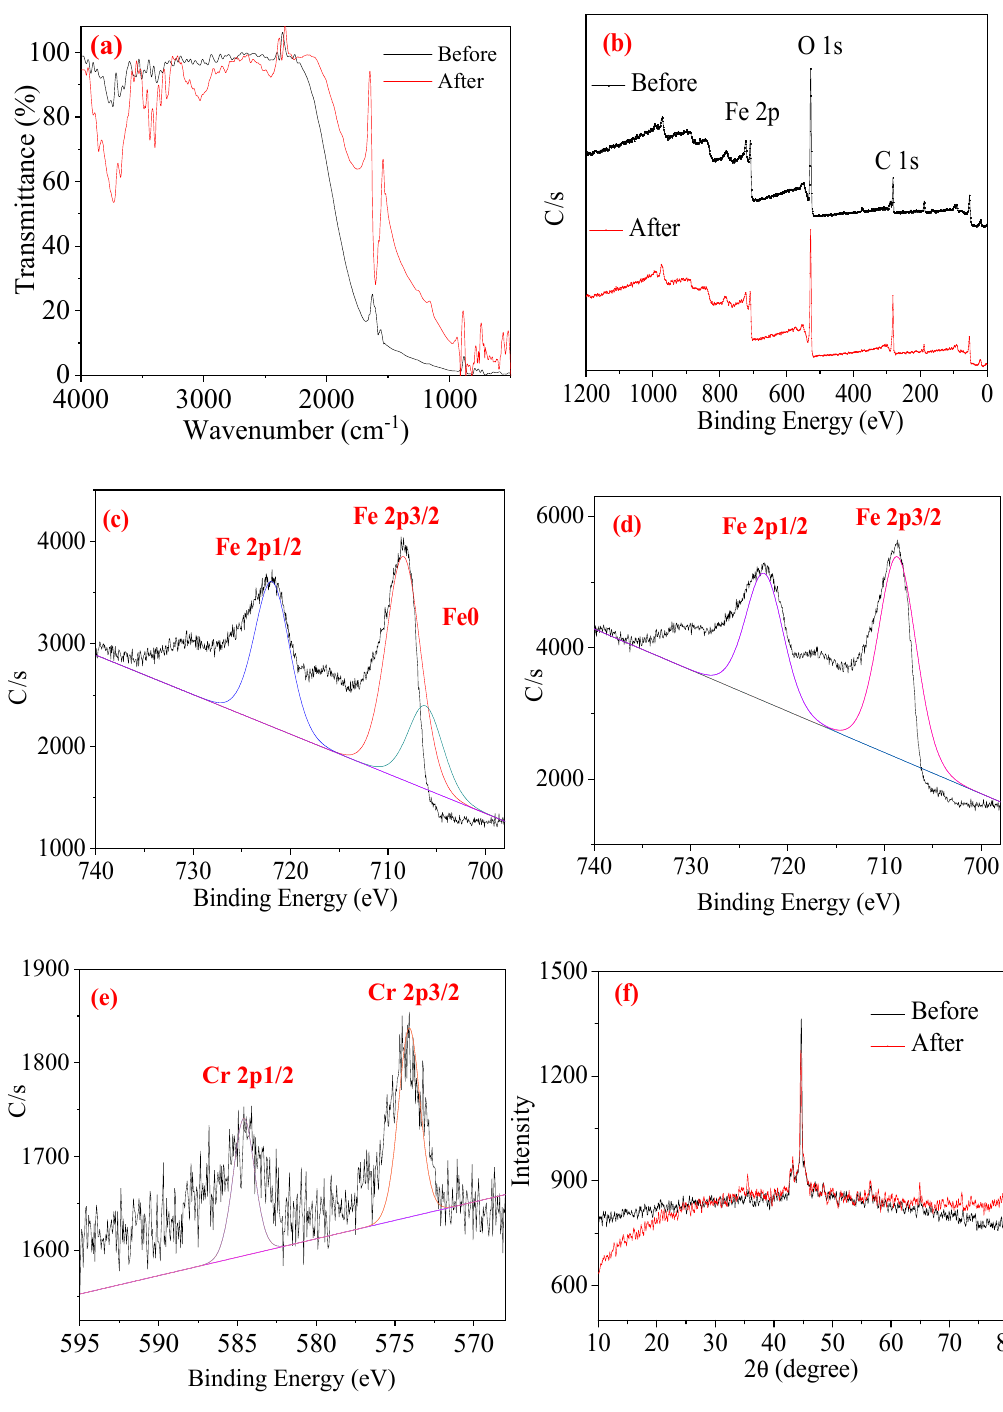
Figure 9. ( a ) The FTIR results of nZVI pre- and post- reaction with Cr(VI); ( b ) wide-scan XPS survey of nZVI before and after Cr(VI) adsorption; a magnified region in the XPS survey of nZVI before ( c ) and after ( d ) Cr(VI) adsorption; ( e ) a high-resolution Cr XPS survey of nZVI before and after Cr(VI) adsorption; ( f ) XRD analysis of nZVI before and after the reaction. ([Cr(VI)] = 25 mg/L, [nZVI] = 0.5 g/L, pH = 3, T = 293 K, Time = 120 min).